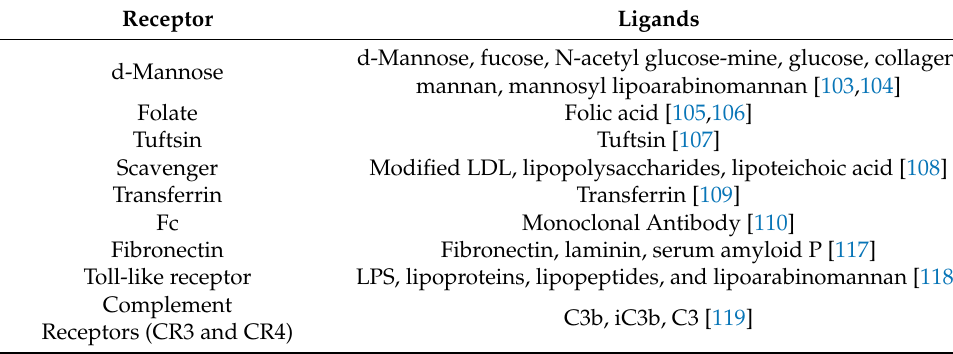
Table 2. Macrophage receptors and their specific ligands.